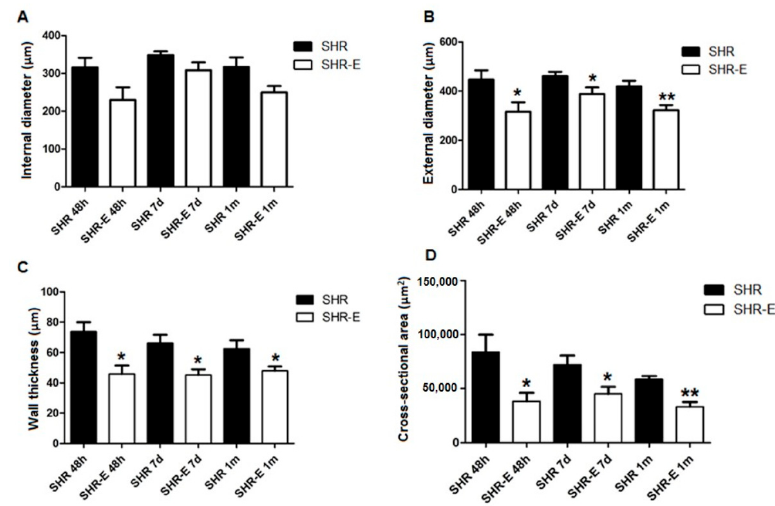
Figure 2. Structural parameters (medial + adventitial layers) of the coronary artery. Lumen diameter ( A ), external diameter ( B ), wall thickness ( C ), and cross-sectional ( D ) in treatment groups (48 h) and withdrawal groups (7 days and 1 month). SHRs, rats treated with vehicle; SHR-Es, rats treated with esmolol; n = 9 rats for each experimental group. Values are mean ± SEM. * p < 0.05, ** p < 0.01 vs. SHRs.